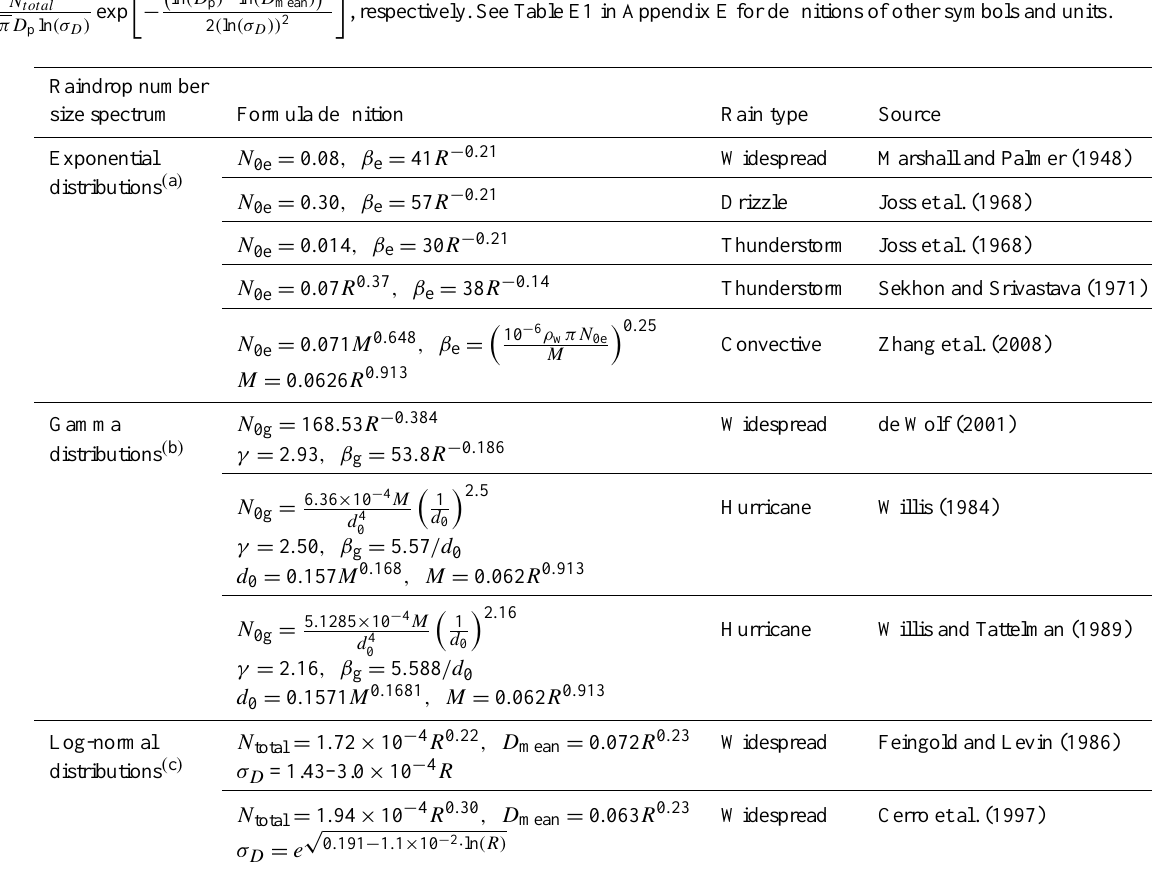
Table 2. List of raindrop number size distribution ( N(D p )) formulas. The general forms of the (a) exponential, (b) gamma, and (c) log-normal distributions are commonly written as N(D p ) = N 0e exp (cid:0) − β e D p (cid:1) , N(D p ) = N 0g D γ p exp (cid:0) − β g D p (cid:1) , and N (cid:0) D p (cid:1)